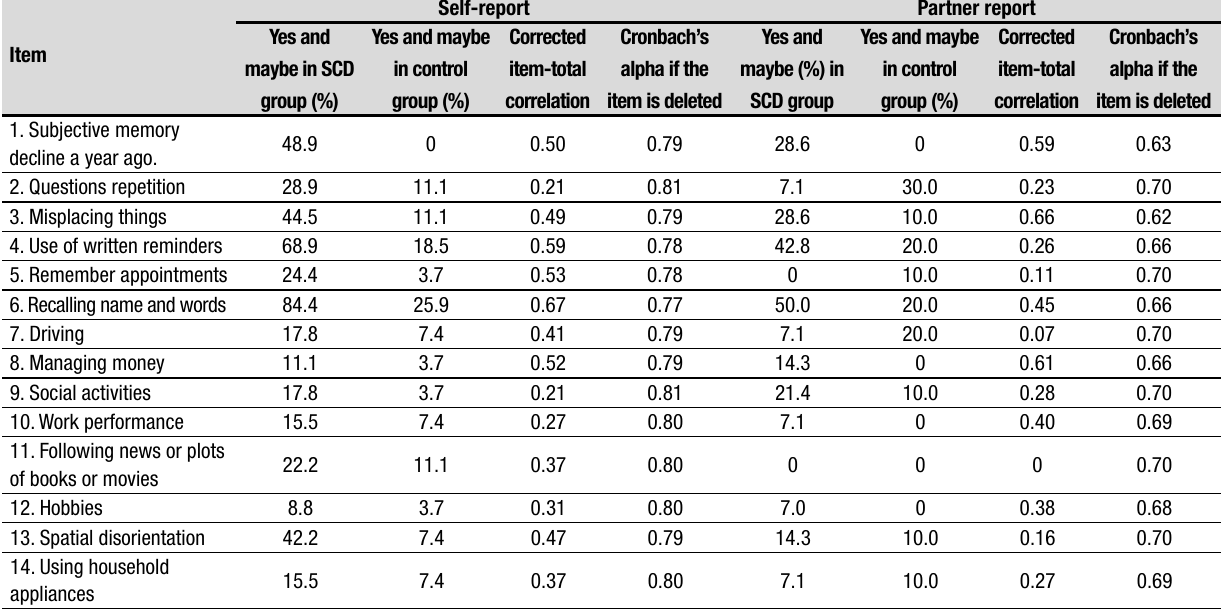
Table 2. Percentages of positive answers (yes and maybe) for each item of Cognitive Function Instrument, corrected item-total correlation, and internal consistency (Cronbach’s alpha) if the item is deleted in a sample of cognitively normal elderly with and without subjective decline